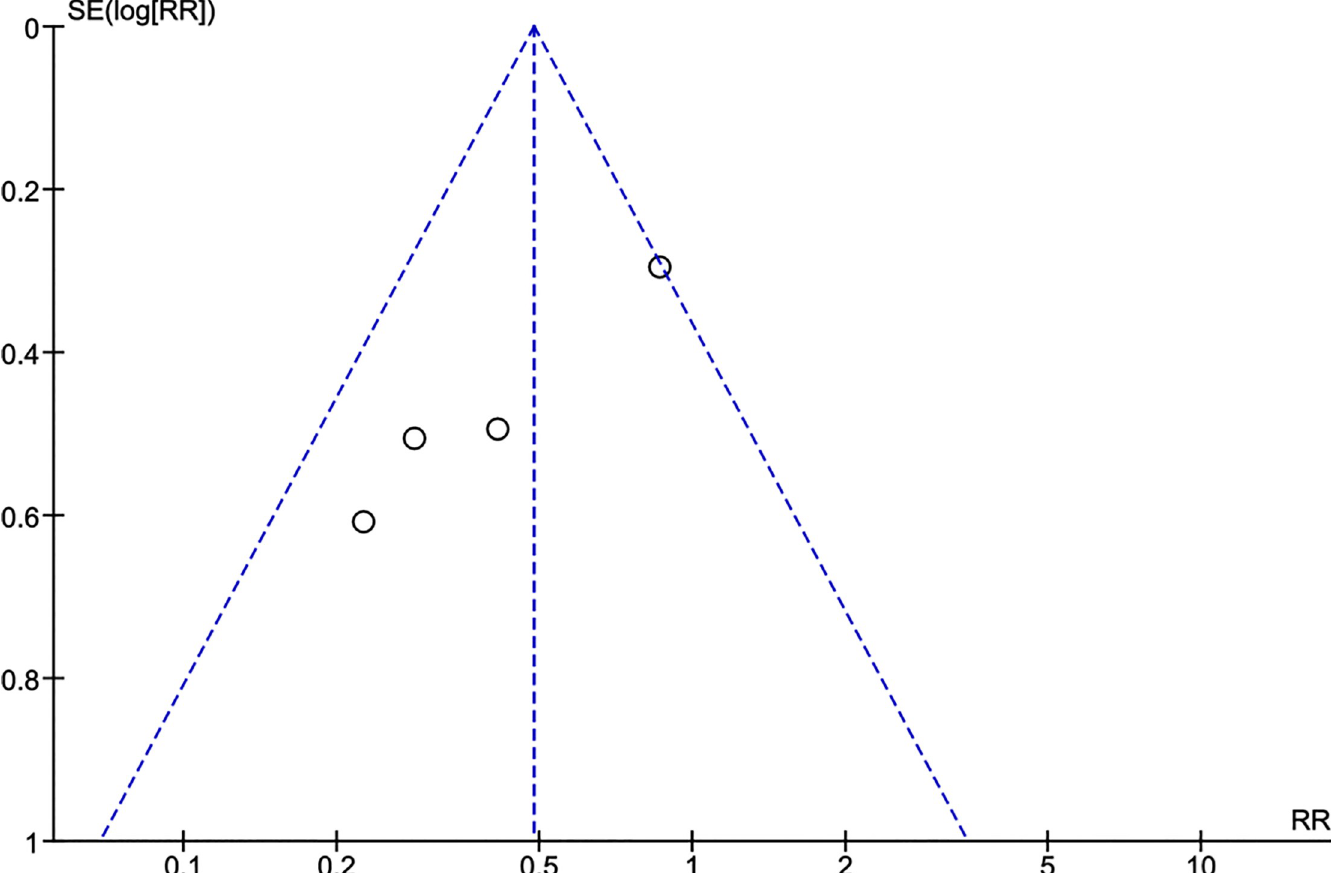
Fig 12. Funnel plot anti-inflammatory treatment. Corticosteroids versus no corticosteroids. Outcome: seizure